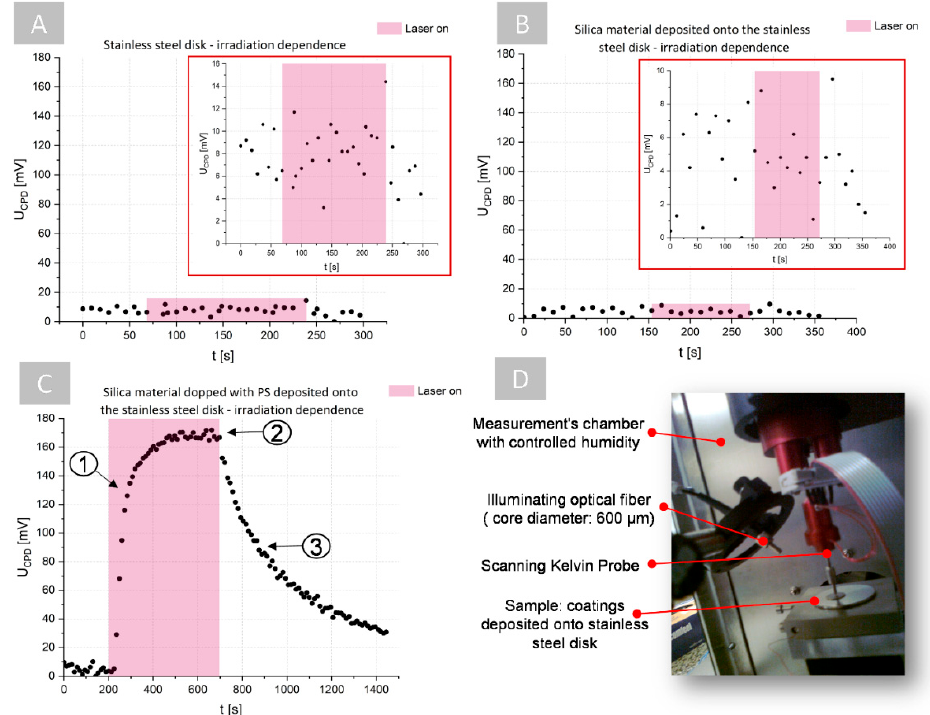
Figure 5. The changes of U CPD of different surfaces (RH = 80%): ( A ) stainless steel, ( B ) stainless steel with silica coating, and ( C ) stainless steel with PS-doped silica coating depending on the laser irradiation at 655 nm wavelength (red regions represent surface exposition to laser light—laser on, 1—generation of free radicals, 2- saturation of the generation of free radicals, and 3- exponential decrease in free radical generation), ( D ) the used measurement setup.